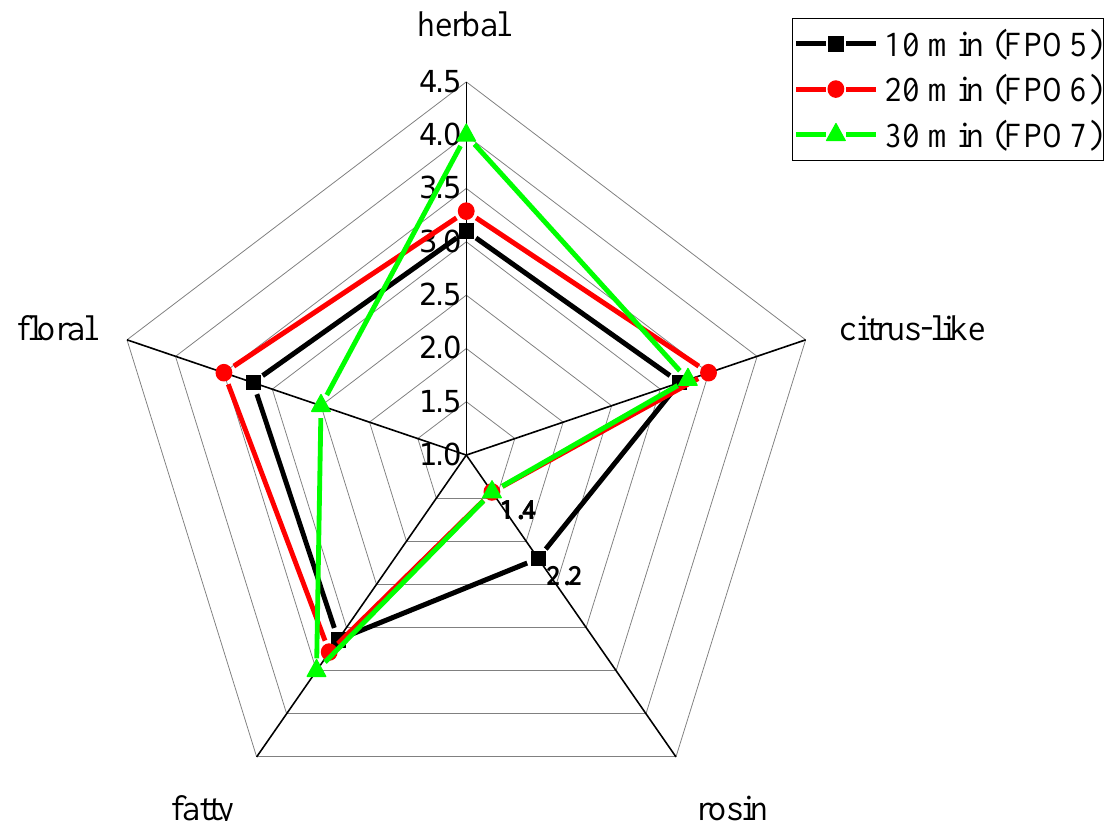
Figure 3. Aroma profiles of FPOs with different frying